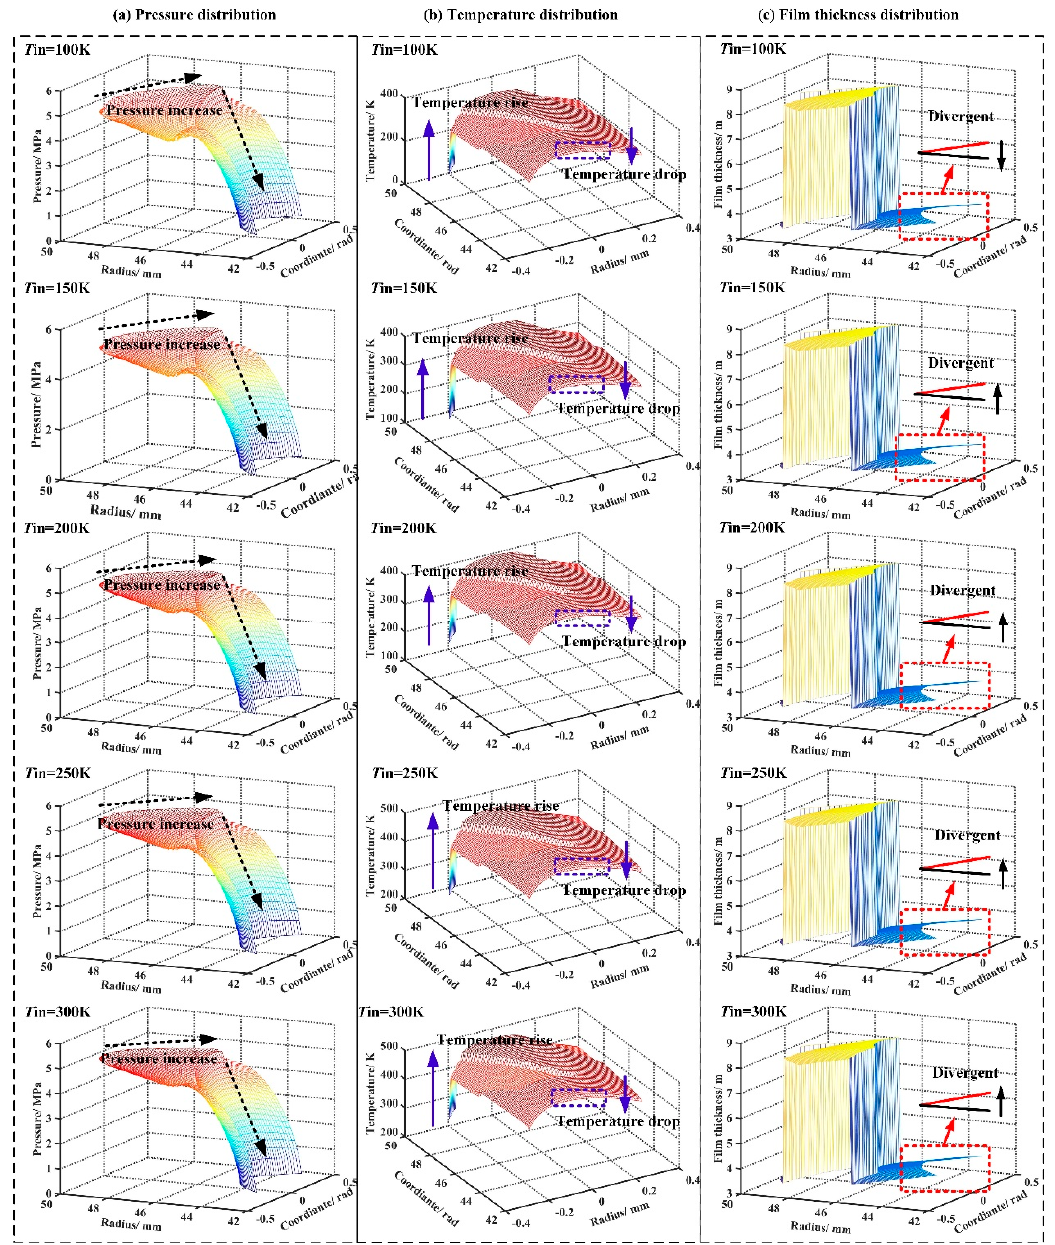
Figure 7. Distributions of the pressure, temperature, and film thickness with respect to the sealing temperature. ( P in = 5.0 MPa, P out = 0.1 MPa, T out = 350 K, n = 50,000 rpm, h 0 = 3 μ m).